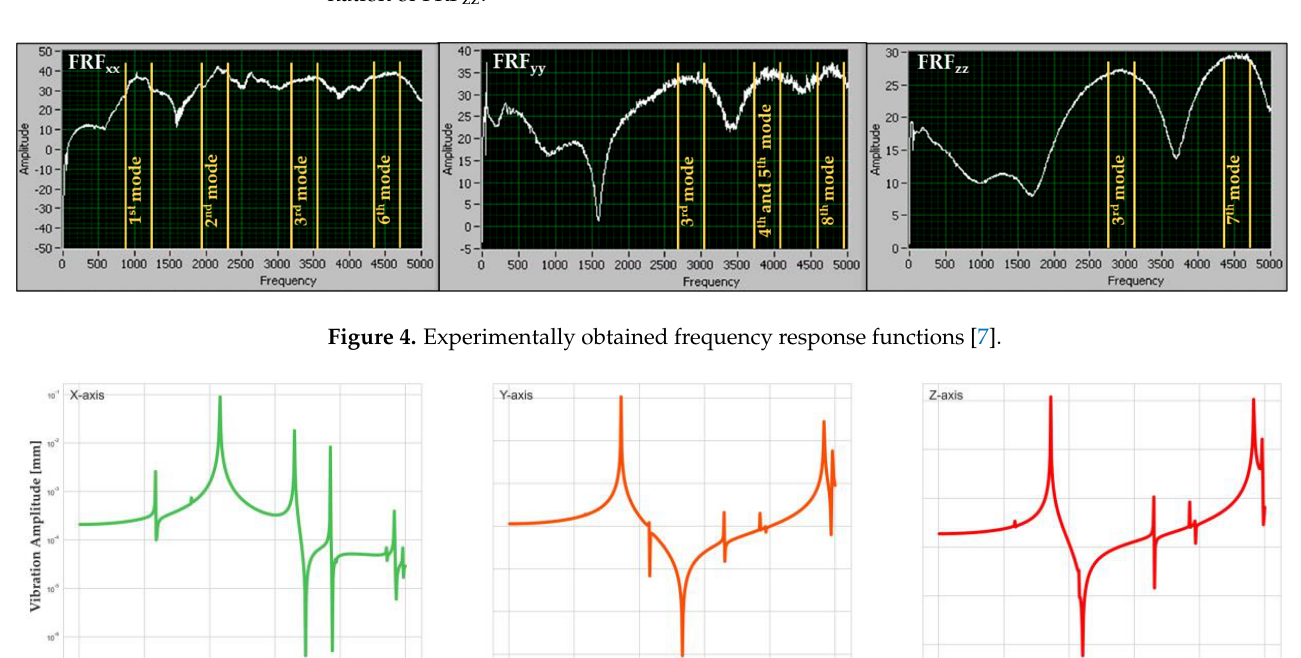
Figure 3. Impact hammer ( left ) and accelerometer ( right ) signals during impact testing for determi- nation of FRF zz .